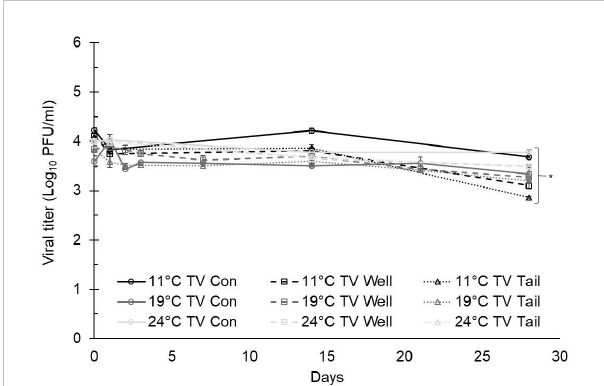
FIGURE 1 Tulane virus (TV) infectivity in ultrapure (control), well, and tail water samples held at 11, 19, and 24°C and assessed for 28 days. Viral titer is reported as PFU/ml. Data points are the average of six replicates. Error bars represent ± standard deviation. * denotes signi fi cant difference (p<0.05) compared to day 0 within the same treatment group.